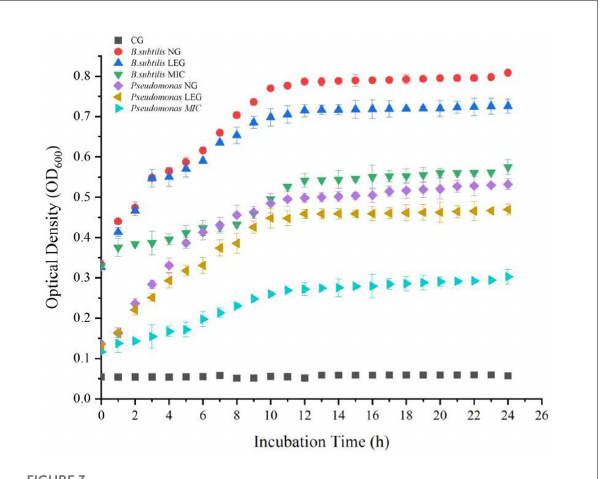
FIGURE 2 Effect of preservation methods on the hydrophobicity of mussel protein surface. CG, the control group; CPG, the compound preservative group; LEG, the low voltage variable frequency electric field group; CP+LEG, the compound preservative combined with low voltage variable frequency electric field group. At the same storage time, different lowercase letters indicate significant differences between groups; Within the same processing group, different uppercase letters indicate significant differences within the group ( p < 0.05). Data were obtained as the mean ± standard deviation ( n = 3).